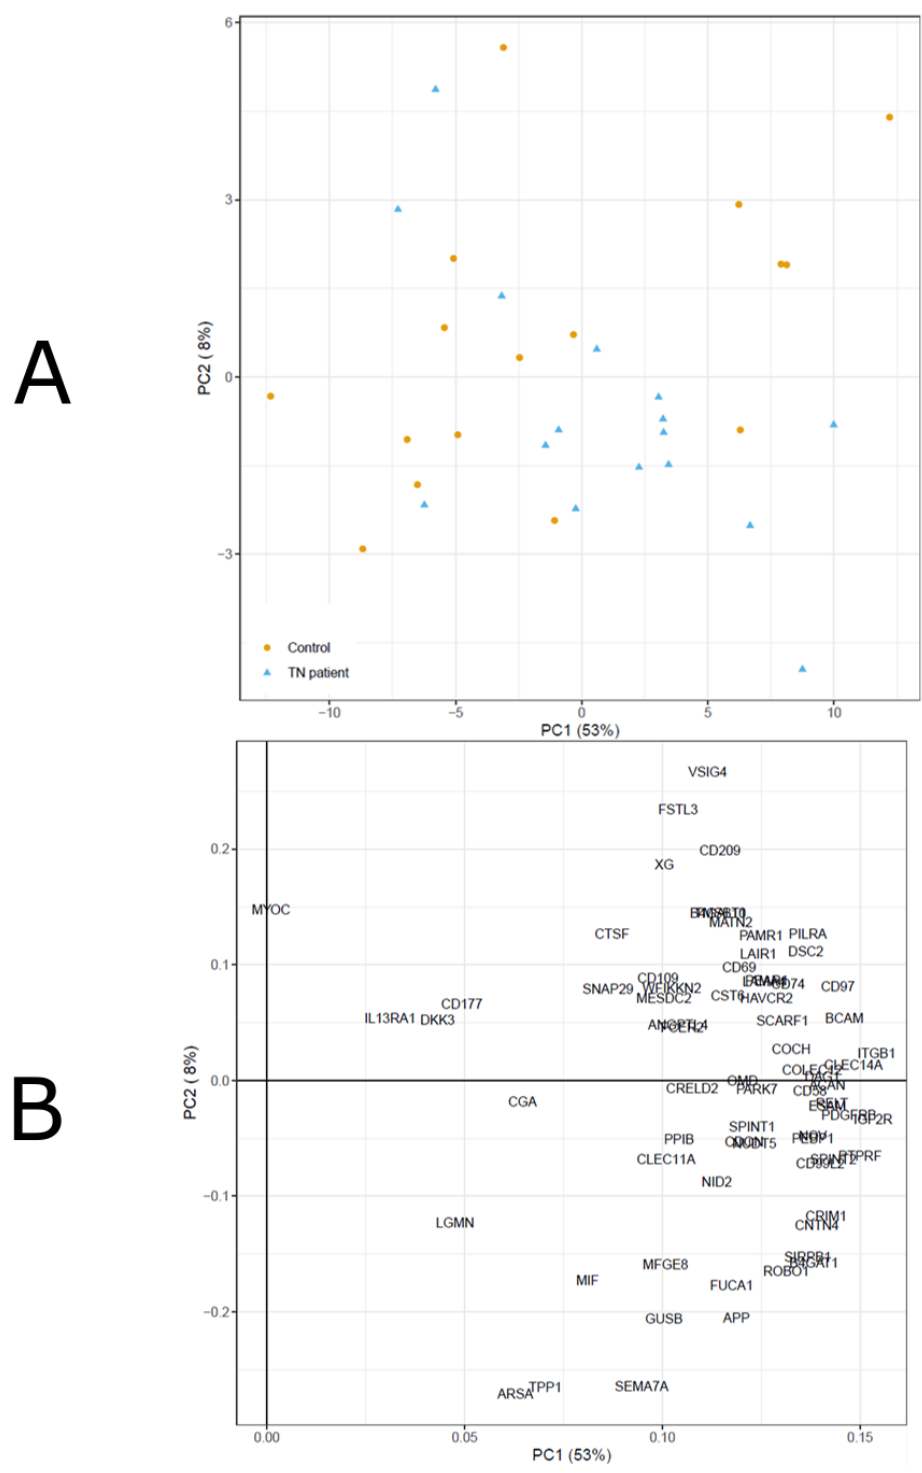
Figure 1. ( A , B ). CSF biomarkers in TN patients and controls — a PCA analysis.